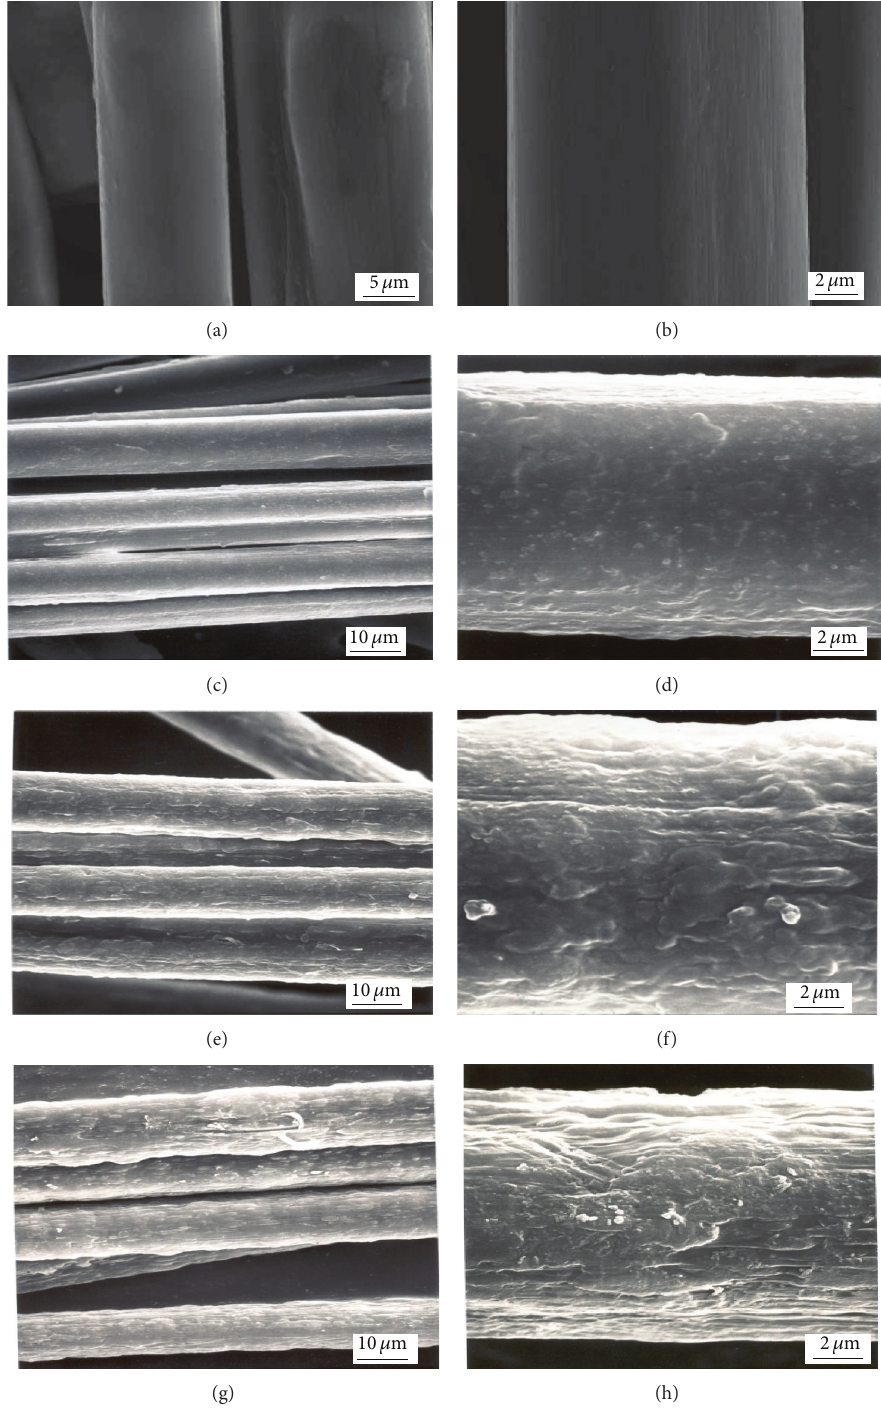
Figure 2: SEM photographs of chitosan fiber (a and b) as well as 10/90 (c and d), 20/80 (e and f), and 30/70 (g and h) HAp/chitosan hybrid